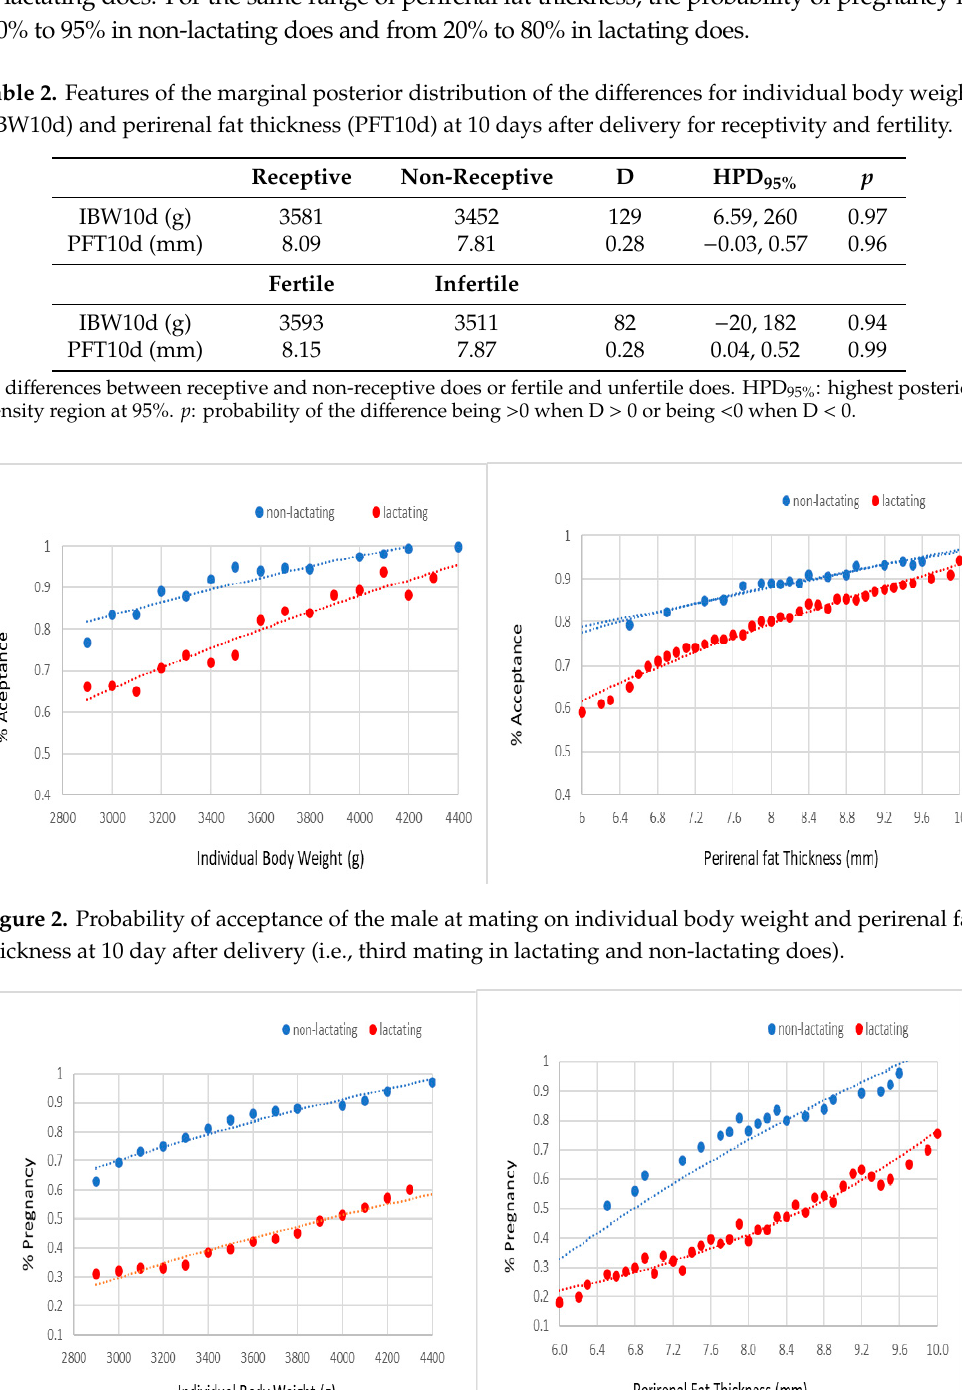
Table 2. Features of the marginal posterior distribution of the differences for individual body weight (IBW10d) and perirenal fat thickness (PFT10d) at 10 days after delivery for receptivity and fertility. Receptive Non-receptive D HPD 95%